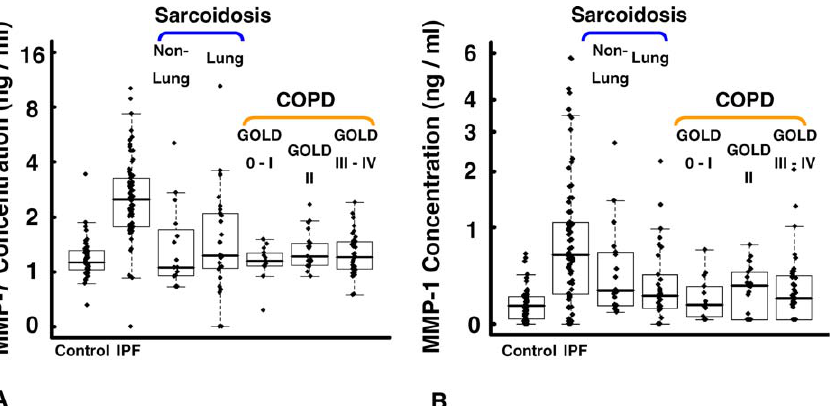
Figure 3. MMP7 and MMP1 Plasma Concentrations Are High in IPF, but Not Sarcoidosis or COPD Concentrations (ng/ml) of MMP7 (A) and MMP1 (B) are significantly higher in patients with IPF ( n ¼ 74; p , 0.00001 and p ¼ 0.018, respectively), compared to controls ( n ¼ 53), but not sarcoidosis ( n ¼ 47; p ¼ 0.78 and p ¼ 0.28, respectively), compared to controls ( n ¼ 53) or COPD ( n ¼ 73; p ¼ 0.21 and 0.85, respectively, stratified by GOLD class, as 0–I, II, and III–IV).